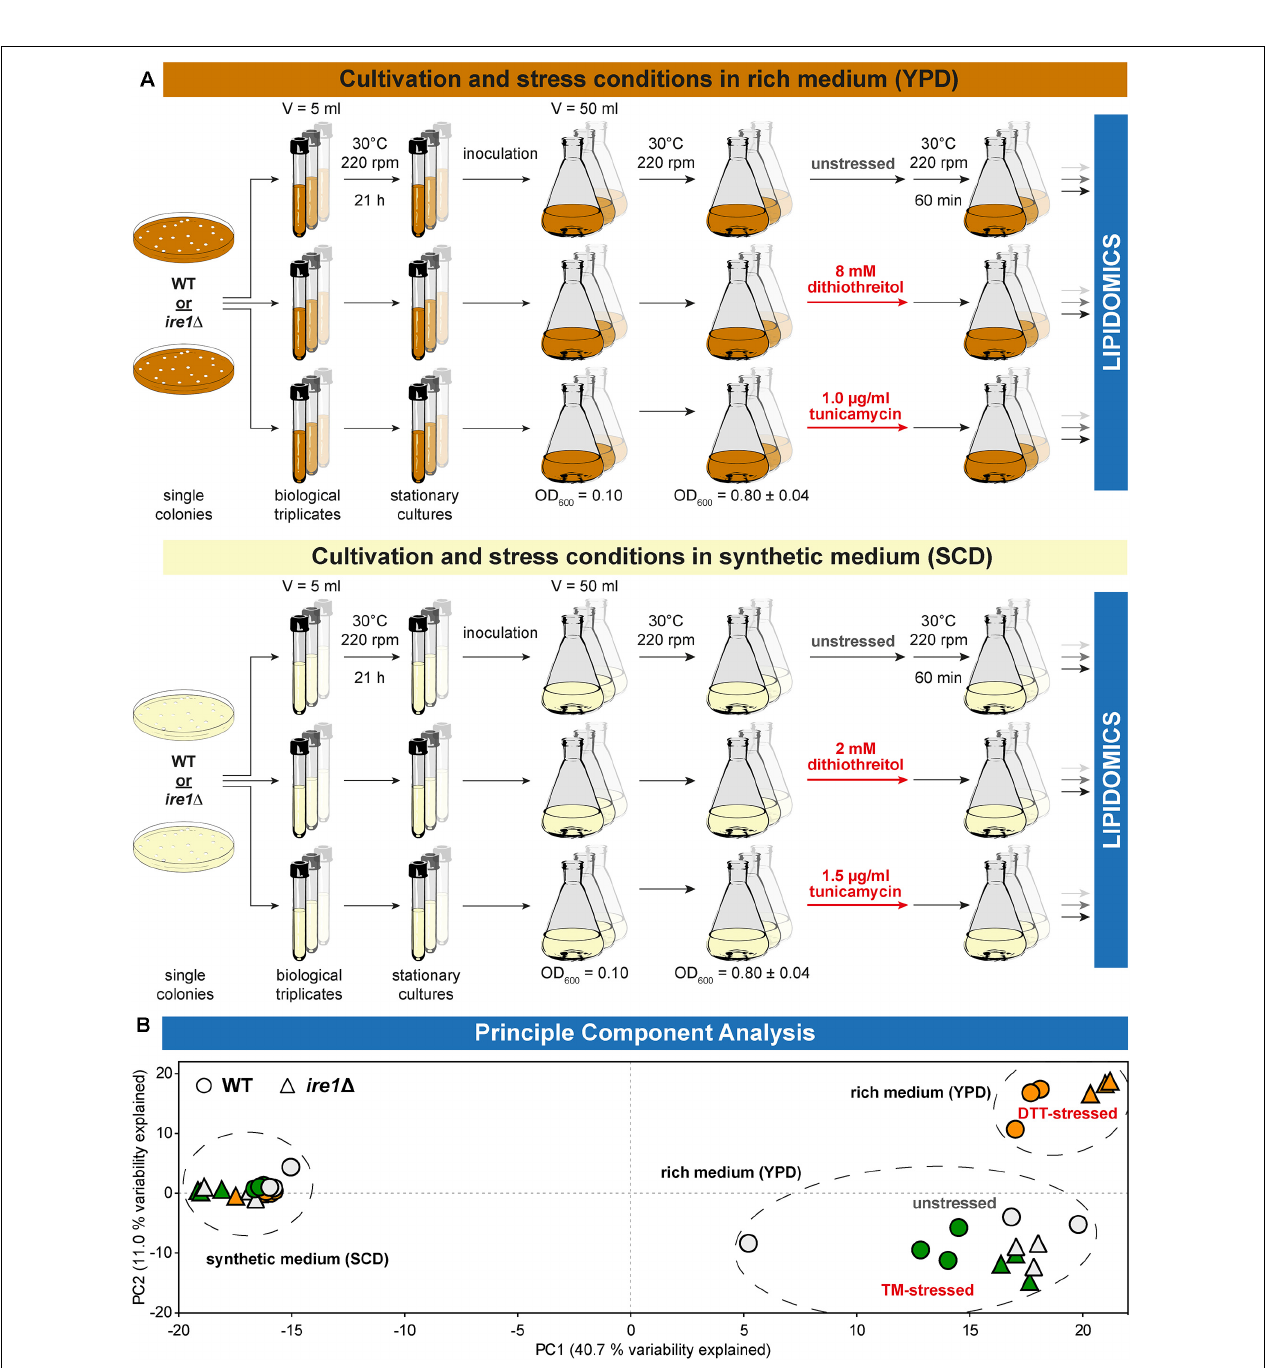
FIGURE 2 | Experimental conditions affecting lipidome variability. (A) Overview of the cultivation and stress conditions use for lipidomic analysis. (B) A two-dimensional principal component analysis (PCA) of lipid species abundances reveals the degree of variations between different cultivation and stress conditions. Data from BY4741 WT and ire1 (cid:49) cells are indicated by circles and triangles, respectively. The color of the data points indicates unstressed cells in gray and cells stressed either with DTT (orange) or TM (green). Data from stressed and unstressed cells are indicated red and gray, respectively. PCA reveals that the lipidomes from both stressed and unstressed cells cultivated in synthetic medium (SCD) are very similar. In contrast, DTT induces a characteristic remodeling of the lipidome of both WT and ire1 (cid:49) cells cultivated in rich medium (YPD).